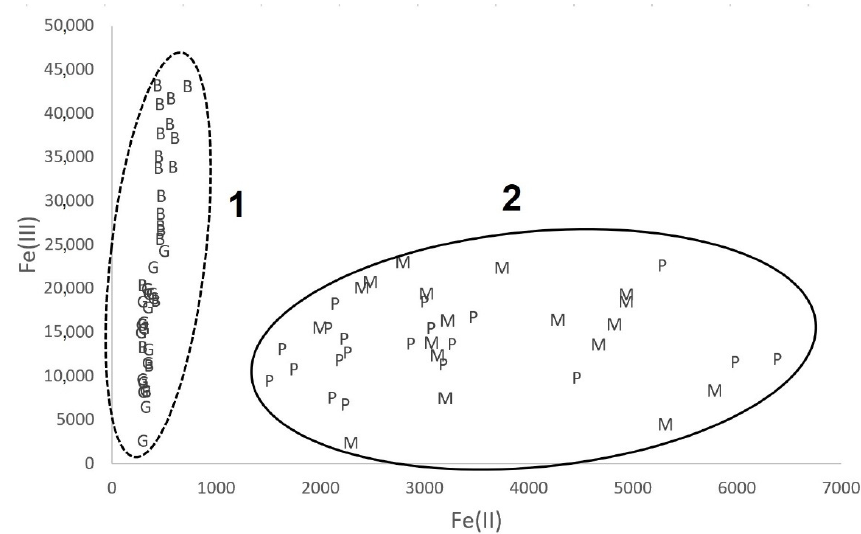
Figure 2. The iron speciation in pottery samples: 1—the group of samples from sites Borzejewo (B) and Grabkowo (G); 2—the group of samples from sites Pozna ń -Nowe Miasto (P) and Moldova(M).